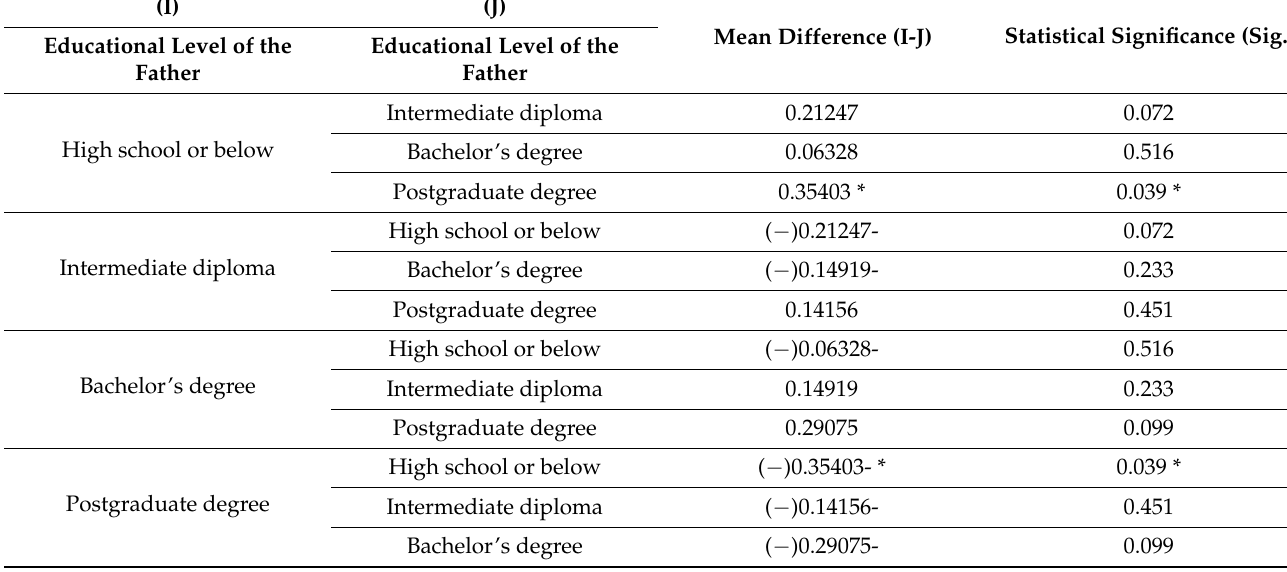
Table 7. Results of Scheffe’s post-hoc test, used to find the source of the differences in the level of familial obstacles to youths’ participation in voluntary work attributed to variance in the educational level of